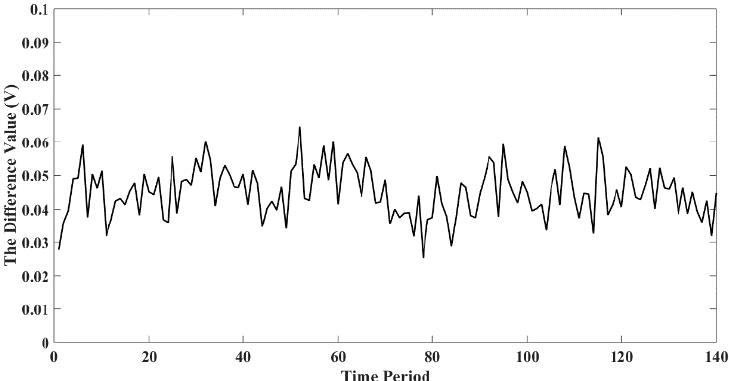
Figure 22. The amplitude difference between the first probe and the second probe.